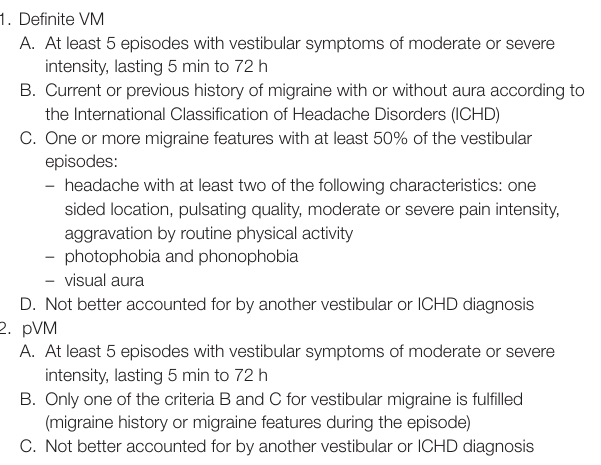
TaBlE 1 | Diagnostic criteria for definite and probable VM